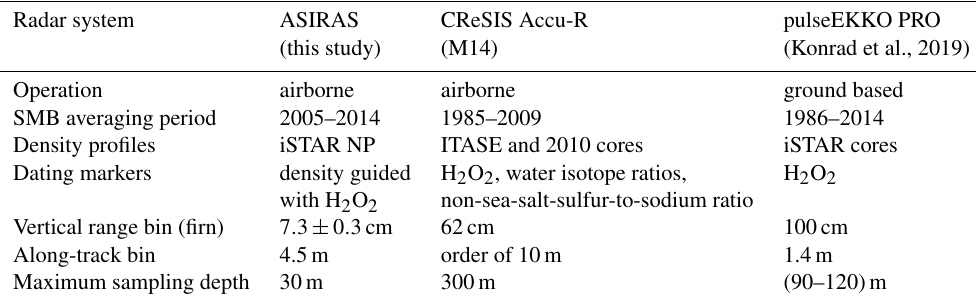
Figure 1. ASIRAS–iSTAR survey projected on polar stereographic coordinates: black lines denote the ASIRAS flight track, numbered blue circles the iSTAR sites with shallow ( ∼ 13m) neutron probe snow density measurements, and magenta–blue circles iSTAR sites with additional deep ( ∼ 50m) firn core measurements of H 2 O 2 during traverse T2. Surface flow speeds from Rignot et al. (2017) are overlaid by colour shadings on top of Landsat imagery (U.S. Geological Survey, 2007). Dotted lines denote basin outlines based on Fretwell et al. (2013) analysis (data accessed via the SCAR Antarctic Digital Database on 23 April 2019). Table 1. Approximate sample bin resolution and maximum depth of SAR level_1b processed ASIRAS data with indicated standard deviation of the vertical range bin based on the two-way-travel time (TWT)-to-depth conversion of this study, CReSIS accumulation radar according to M14, and pulseEKKO PRO GPR discussed in Konrad et al. (2019). For the GPR system we estimate the maximum sampling depths based on shared radargrams, which resolve the internal stratigraphy at PIG for TWTs up to (1000–1200)ns. Additional information includes the considered averaging periods, density profiles, and type of annual dating markers for each